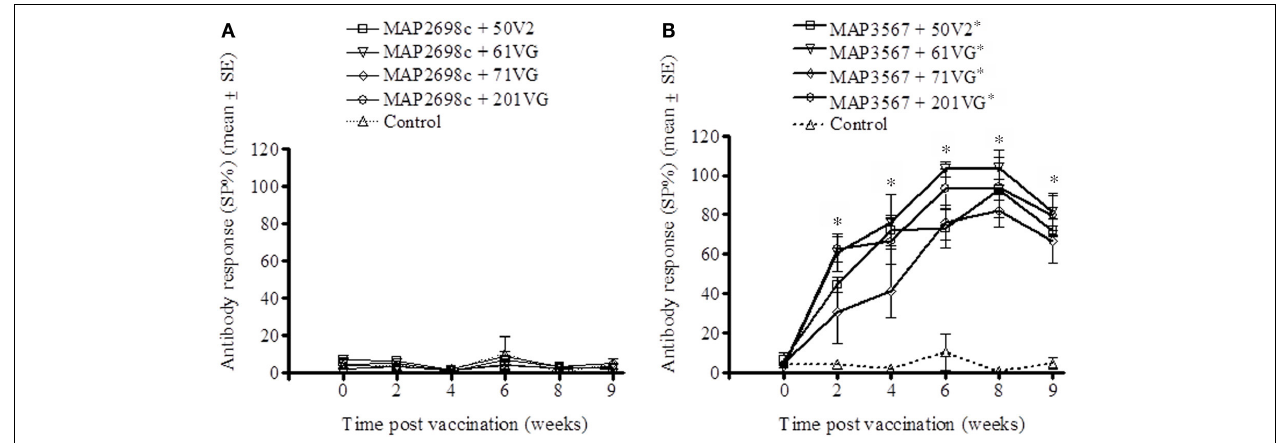
MAP2698c + adjuvants; (B) MAP 316v antibody responses in sheep vaccinated with MAP3567 + adjuvants. Data are mean ± SE . ∗ Significantly higher SP% compared to pre-vaccination ( P < 0 . 05).